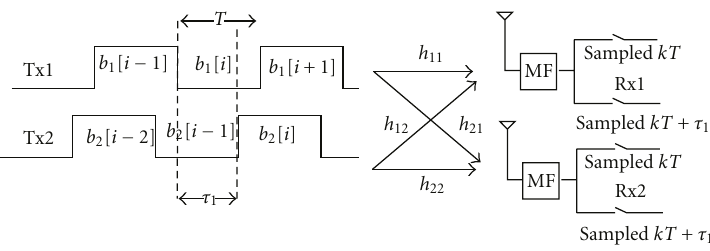
Figure 3: Subsymbol timing o ff set: 2 Tx antennas.